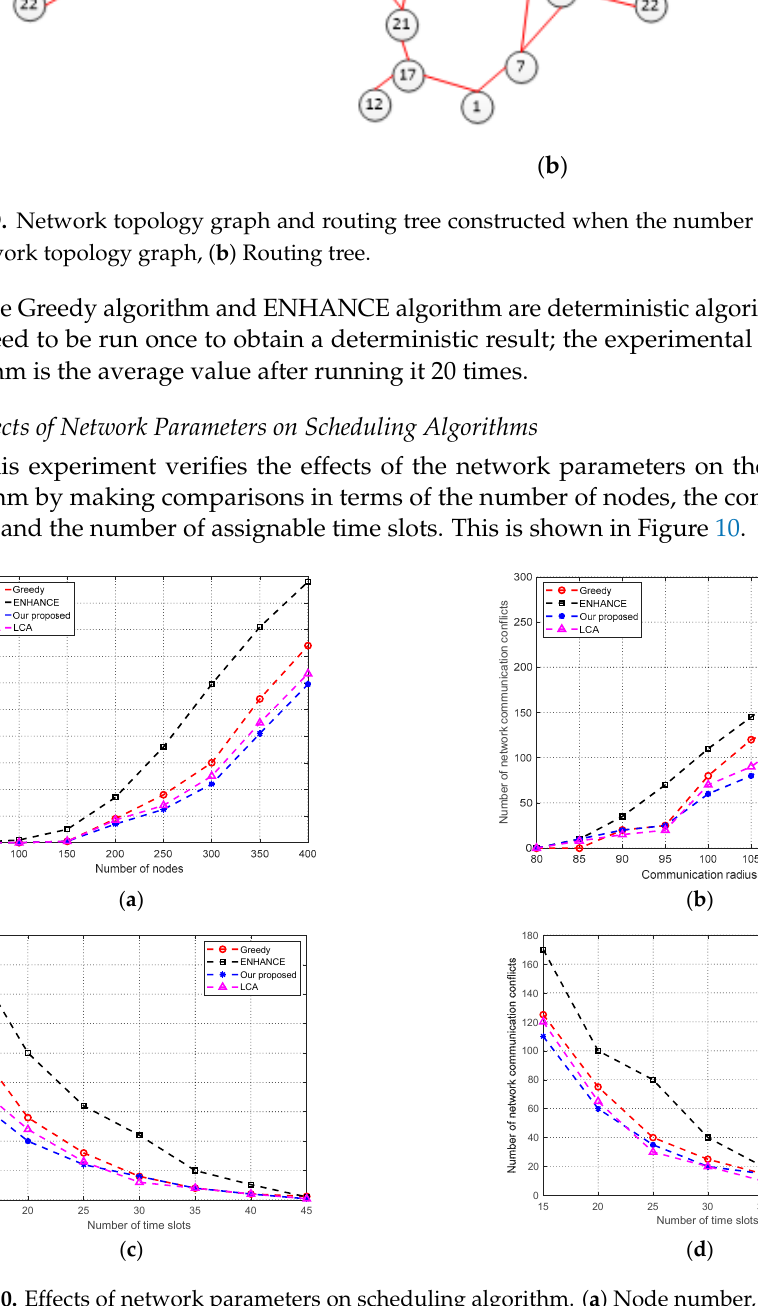
Figure 10. Effects of network parameters on scheduling algorithm. ( a ) Node number, ( b ) Communi- cation range, ( c ) Time slot number (channel is 3), ( d ) Time slot number (channel is